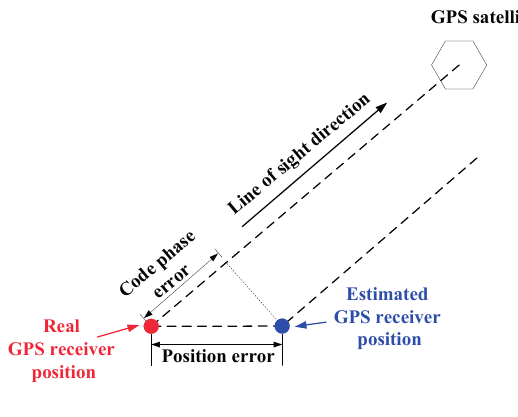
Figure 2. Relationship between GPS receiver position error and code phase